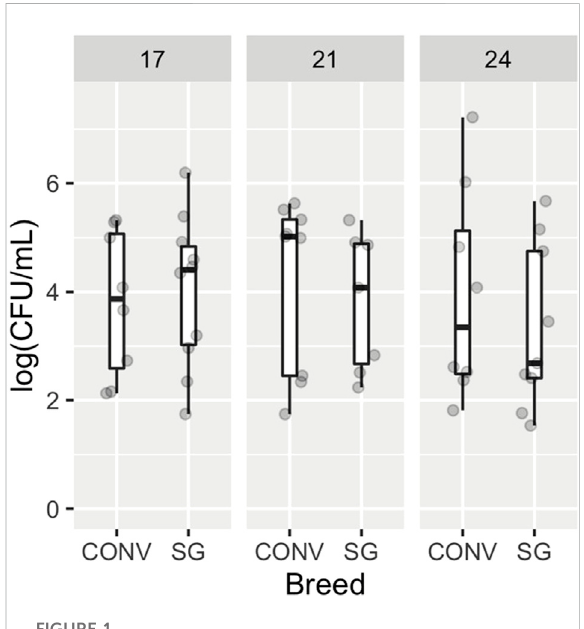
FIGURE 1 Enumeration of Salmonella Typhimurium from cecal contentsofbroilers.Boxandwhiskerplotsindicatetheabundance of Salmonella Typhimurium in log colony forming units (CFU) per ml of cecal contents for conventional (CONV) and slow- growing(SG)broilers,separatedbyage.Pointsrepresentindividual